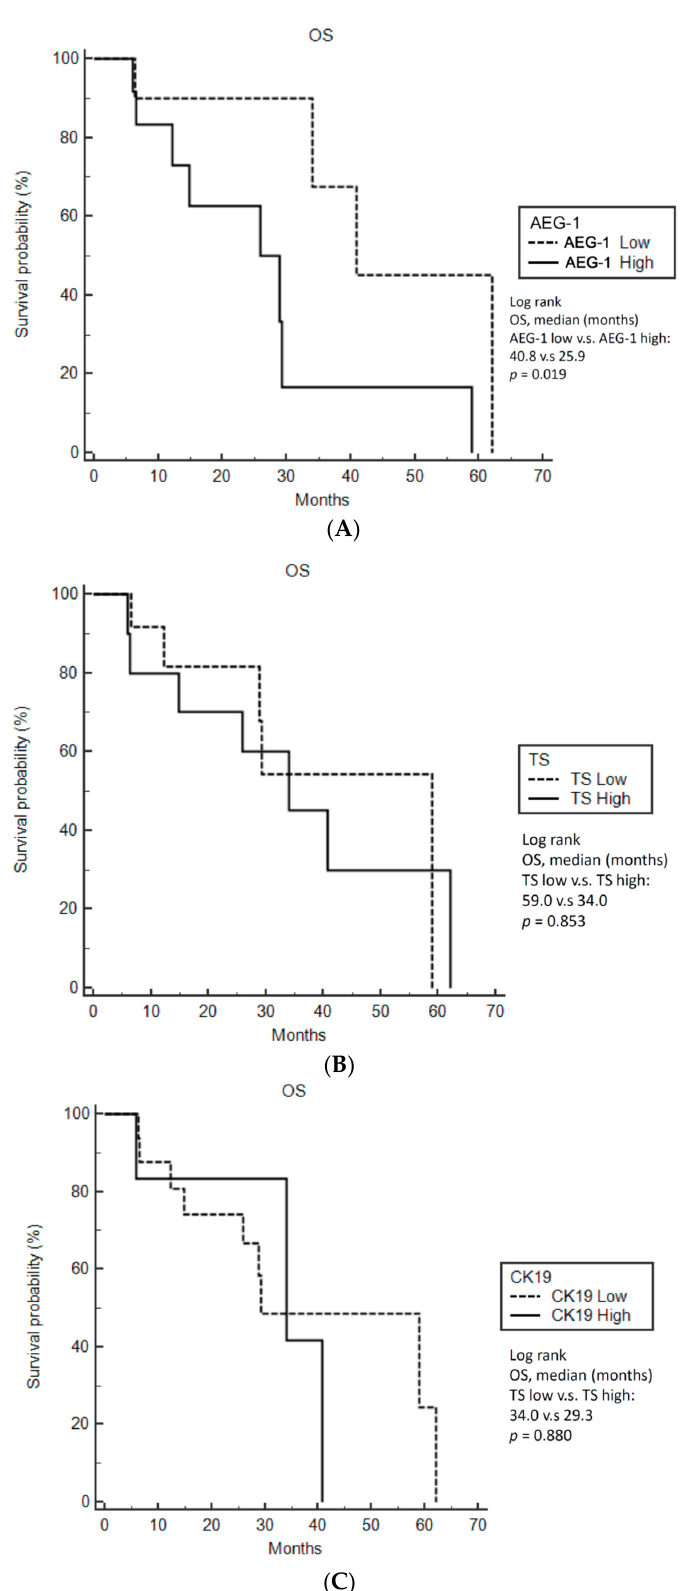
Figure 4. Overall survival (OS) for patients with expression level of plasma biomarker plots by Kaplan–Meier survival analysis. ( A ) OS for patients with low AEG-1 expression was significantly longer (low vs. high, 40.8 vs. 25.9 months, p = 0.019, log rank test). ( B ) Patients with low and high levels of thymidylate synthase (TS) and ( C ) CK19.